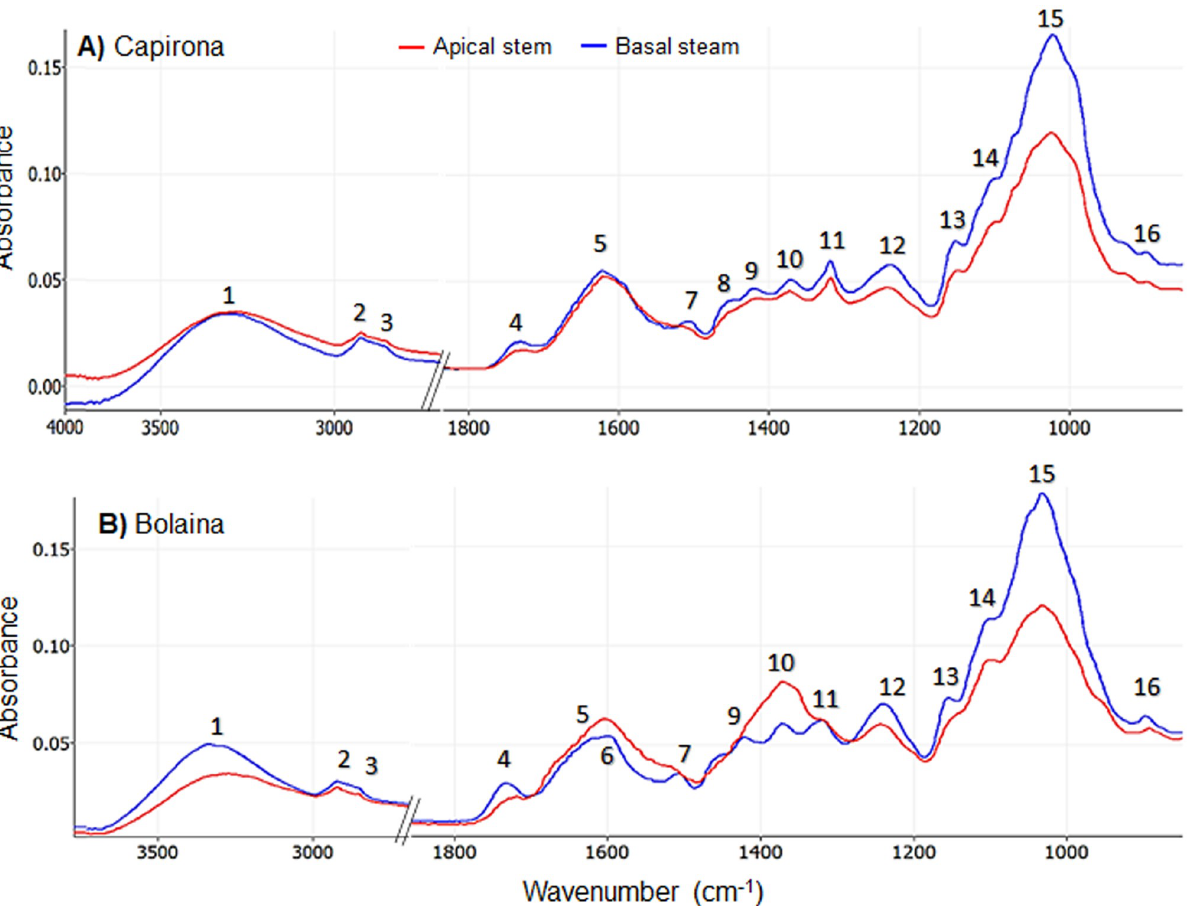
Fig 1. A representative average raw ATR-FTIR spectra from juvenile trees of Capirona and Bolaina.